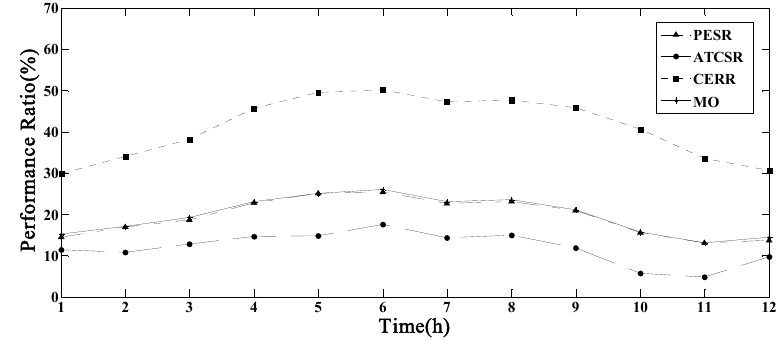
Figure 7. Monthly performance of the RES–CCHP system.